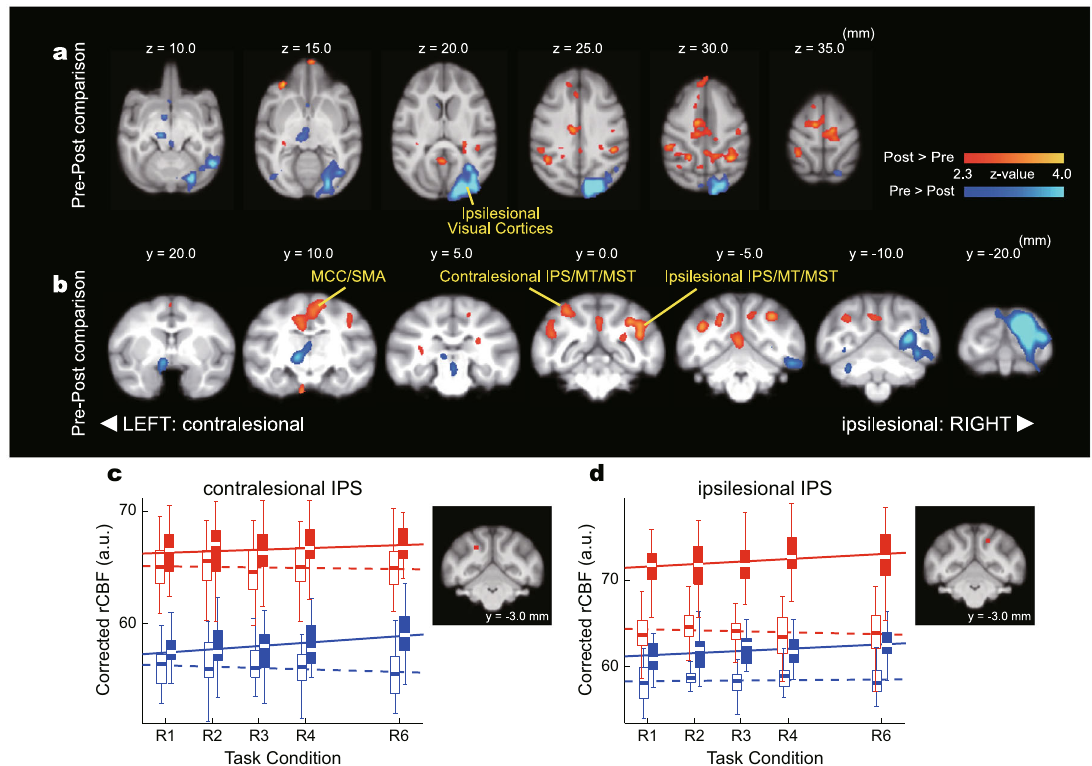
Fig. 4 Interaction effects on rCBF between task and lesion. Interaction effects of task and lesion showing the change in task relation between pre- and post-lesion period. a , b Brain areas with a signi fi cant interaction effect between task condition and lesion. Red-yellow and blue-light blue show a signi fi cant increase and decrease of task relationship in the post-lesion period compared to the pre-lesion period, respectively. c , d The relationship between rCBF (corrected for global signal) and task condition in the contra- and ipsilesional IPS, respectively (regions of Interests were 5 × 5 × 5 voxels around local maxima of post > pre contrast; ipsilesional IPS: x = − 7.5, y = − 3.0, z = 31.0 mm; contralesional IPS: x = 9.5, y = − 3.5, z = 28.5 mm; red squares in each inset). Box plots and regression lines are shown. Blue open boxes with a dotted line indicate monkey C, pre-lesion data. Red open boxes with a dotted line indicate monkey T, pre-lesion data. Blue fi lled boxes with a continuous blue line indicate monkey C, post-lesion data. Red fi lled boxes with a continuous line indicate monkey T, post-lesion data. Regression coef fi cients: ipsilesional IPS in pre-lesion period, monkey C = 0.04, monkey T = − 0.12; ipsilesional IPS in post-lesion period, monkey C = 0.26, monkey T = 0.29; contralesional IPS in pre-lesion period, monkey C = − 0.12, monkey T = − 0.04; contralesional IPS in post-lesion period, monkey C = 0.29, monkey T =